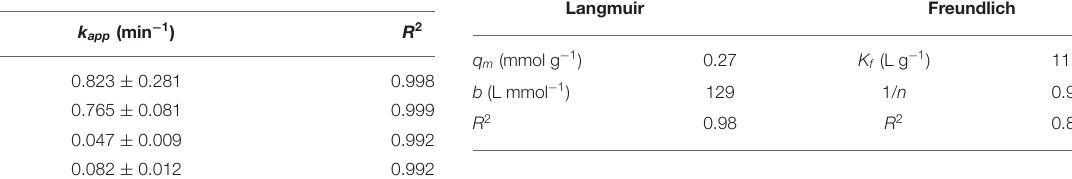
TABLE 3 | First order kinetic constants calculated on the basis of single ion adsorption reported in Figure 6 (ion concentration 1 × 10 − 4 M at pH 5, in presence of SBH-A 800mg L − 1 ).